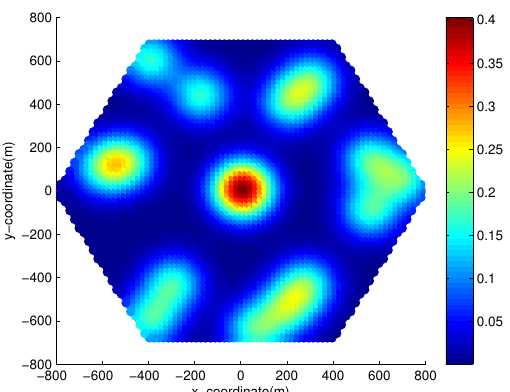
Figure 6. Generated sample MS location MAP.